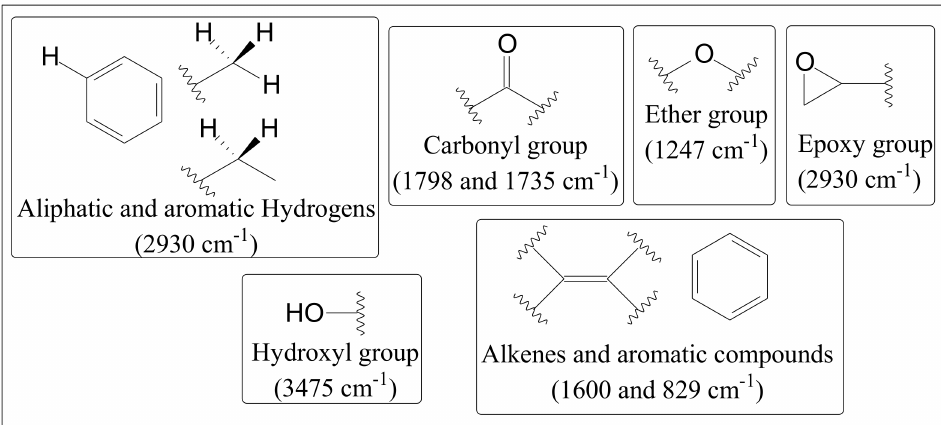
Figure 4. Organic groups identified in the FTIR spectra